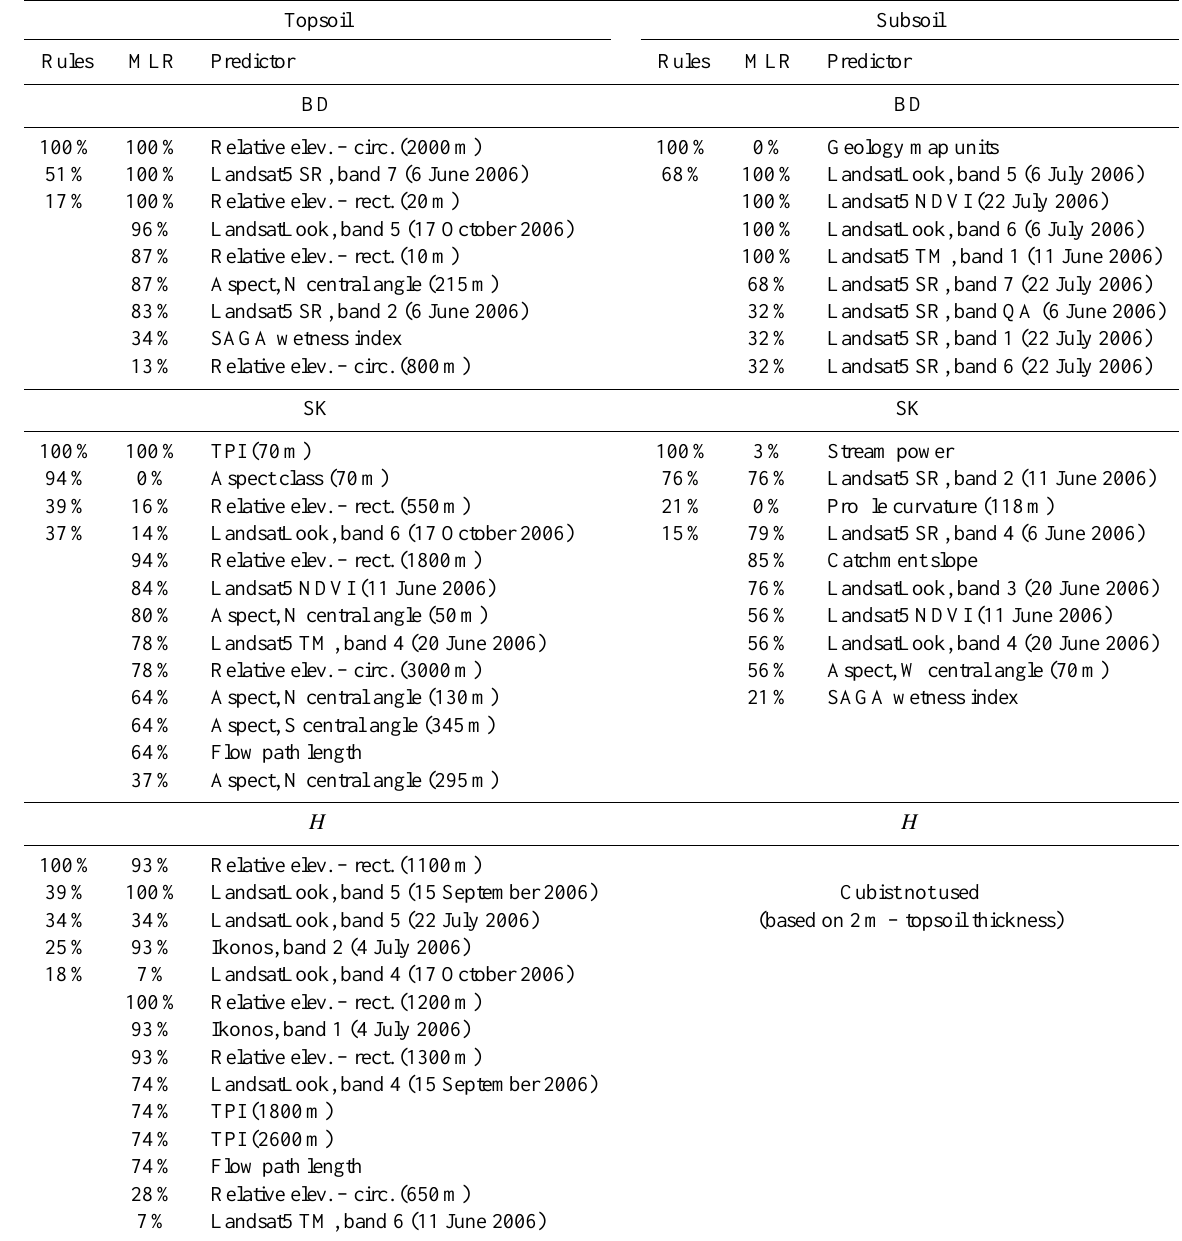
Table 3. Relative use (%) of predictors in models derived by Cubist for the topsoil and subsoil stocks. BD: total bulk density (gcm − 3 ) ; SK: particles > 2mm (%); SOC % : SOC concentration (%); H : stock thickness (cm); and SOC stock : mass of organic carbon per unit area of soil (kgm − 2 )